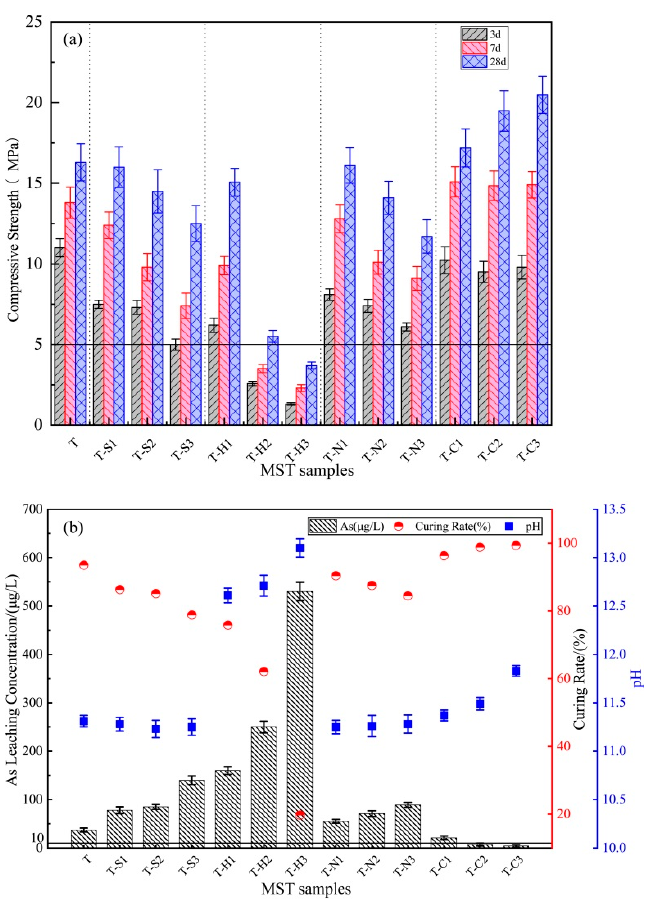
Figure 1. ( a ) UCS of MST samples at 3, 7 and 28 day; ( b ) As leachability of 28 day MST